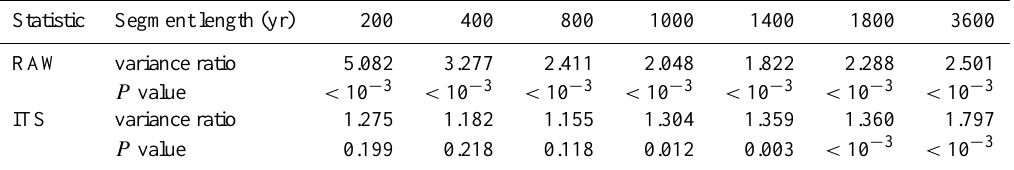
Table 2. Significance of variance changes across the 3150 BCE boundary (grey line in Fig.8) in Laguna Pallcacocha red colour intensity. The table lists P values for a block bootstrap test (25-year blocks, N = 2000 realizations) of the null hypothesis that the variance jump across the boundary could have arisen from chance alone. The test is deemed significant at the α level whenever P ≤ α and is conducted on time segments of variable length, to identify how long an interval is needed to detect a shift in variance. Results are virtually identical to 10-year blocks.